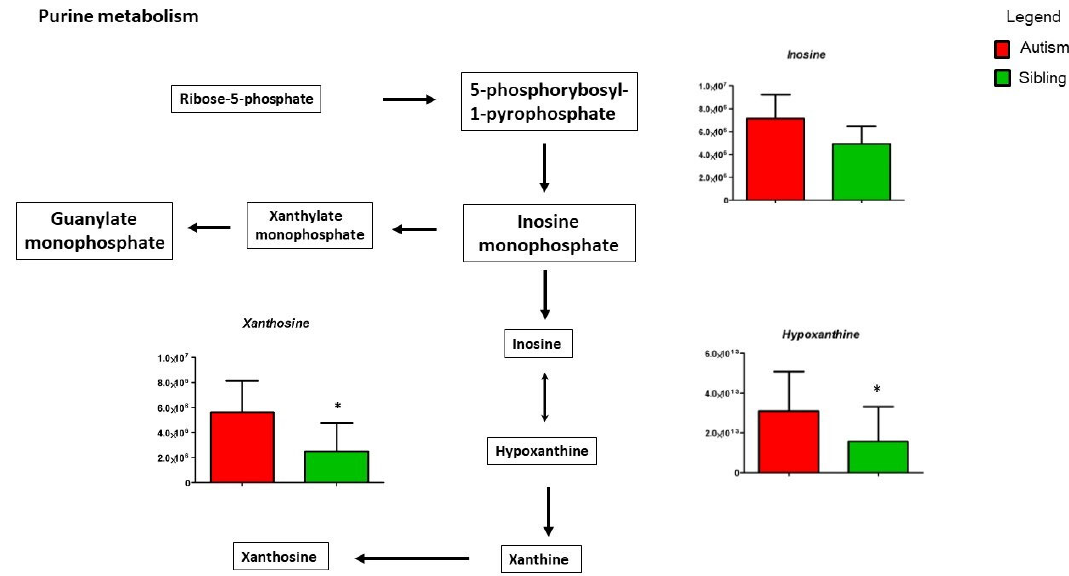
Figure 4. Intermediates of purine pathway are presented as the differences between autistic subjects in red and typically-developing siblings in green. The columns represent the mean ± SD (n = 14) of each metabolite concentration. * p < 0.05.